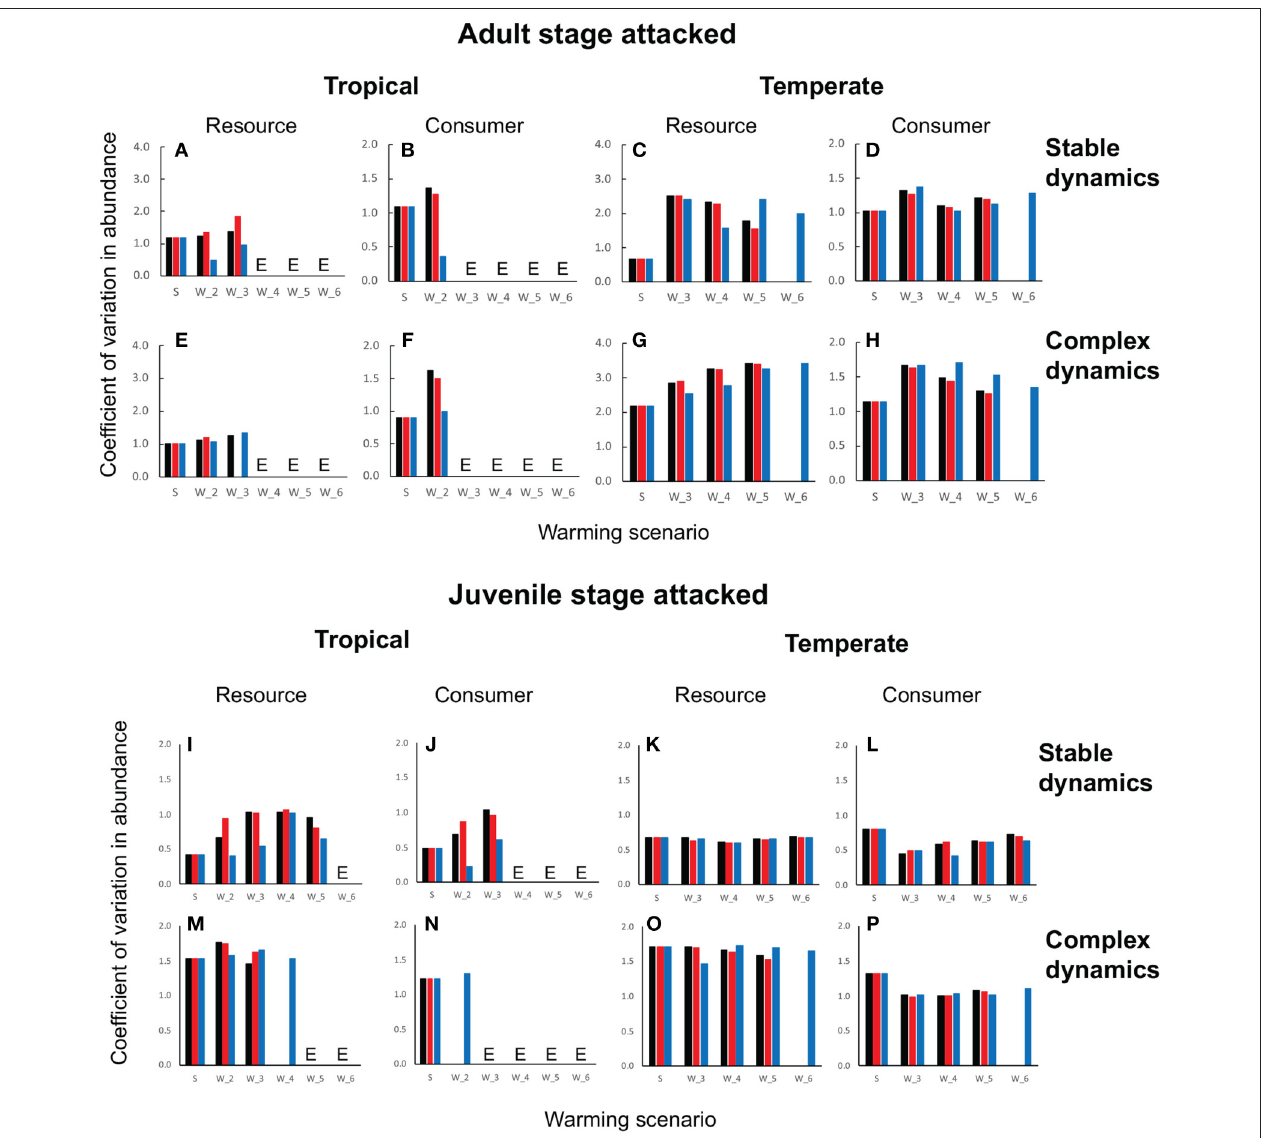
FIGURE 5 | Coefficient of variation in resource and consumer abundances in tropical and temperate habitats when the consumer attacks the adult stage (A–H) vs. the juvenile stage (I–P) . In all panels, the x-axis gives the CV in abundance under typical seasonal variation (S) and successively increasing levels of warming ( W 2 ··· , W 6 ) where W i ( i = 1,6) depicts a warming scenario in which the maximum temperature increases by i ⋆ [e.g., W 2 denotes W 22 (black column), W 12 (red column), and W 21 (blue column). In each panel, the black column depicts warming effects when the minimum and maximum temperatures increase at the same rate, the red column depicts effects when the maximum increases faster than the minimum, and the blue column, when the maximum increases slower than the minimum. In each case (juvenile vs. adult), the top row of panels depicts stable dynamics (A–D) when the adult is attacked and (I–L) when the juvenile is attacked] and the bottom row, complex dynamics (E–H) for adult and [m-(p) for juvenile]. Cases marked with E depict warming-driven extinctions of resource and/or consumer. Parameter values are as in Figures 3 , 4 and Table 1